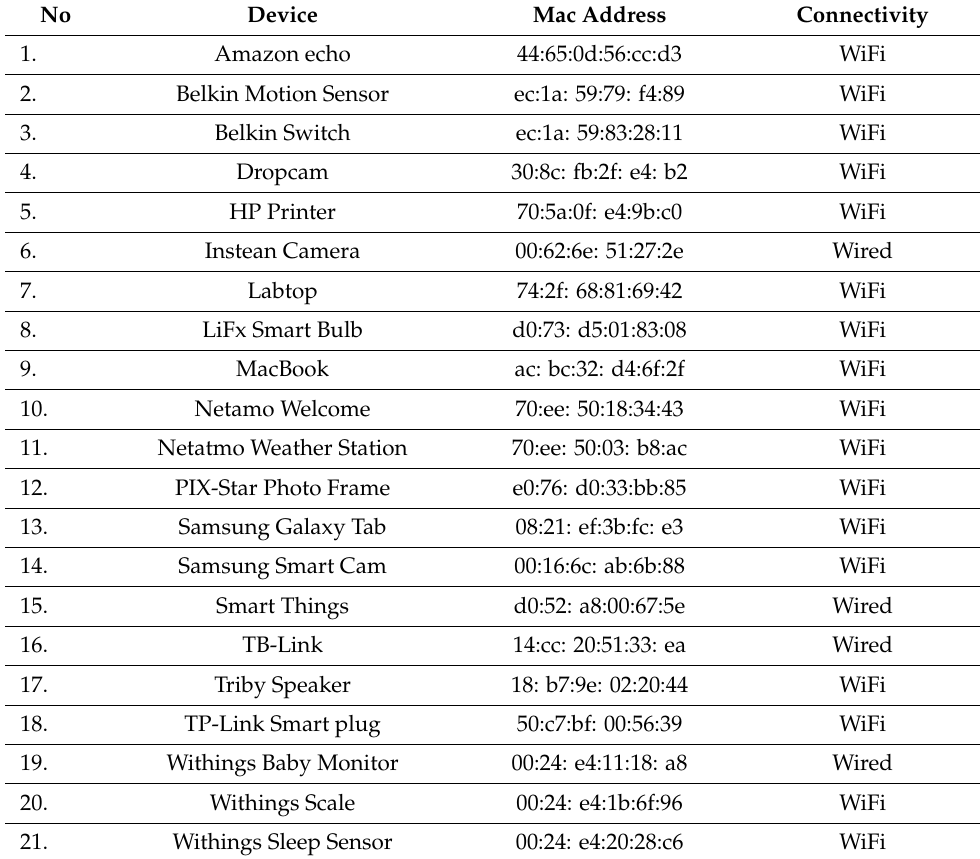
Table 4. List of IoT/non-IoT devices used in the